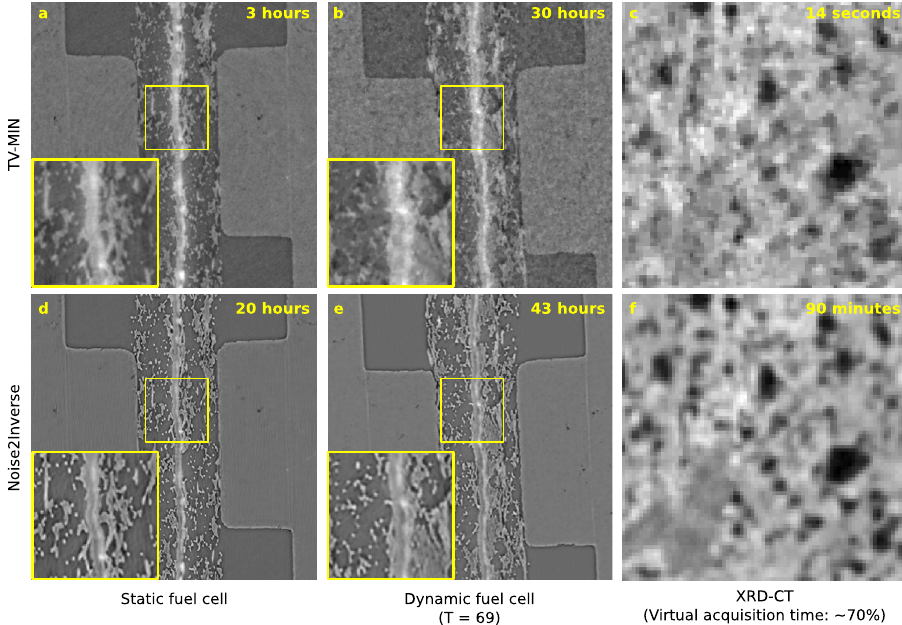
Figure 7. Comparison between Total-Variation Minimization reconstructions ( a - c ) and Noise2Inverse ( d - g ) reconstructions of the static and dynamic micro-tomography datasets of a fuel cell and X-ray diffraction tomography dataset of a ceramic. The displayed regions correspond to the reconstructions displayed in Figs. 4, 5, and 6. Magnifications of the yellow regions of interest are displayed in the lower-left corner of the panels. In the top right corner of each panel, an indication of the reconstruction time of the full dataset is given using four Nvidia GeForce GTX 1080 Ti GPUs. The indicated time was realized for the Noise2Inverse reconstruction and estimated for the TV-MIN